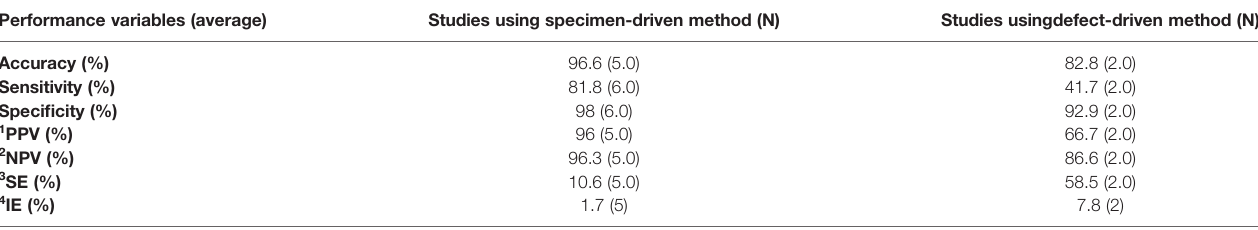
TABLE 6 | The non-weighted average IOARM performance parameters for bone tissue: specimen-driven vs defect-driven method. Performance variables